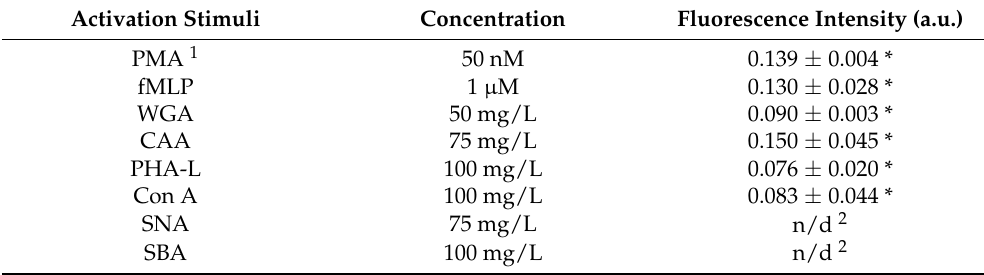
Table 1. Effect of various agonists on HOCl production by neutrophils, detected by CB. Activation Stimuli Concentration